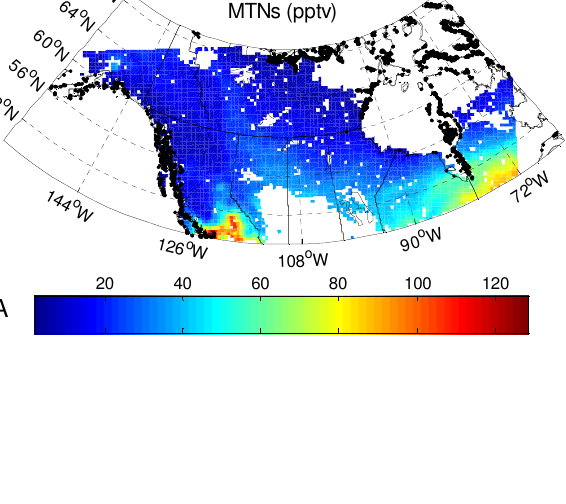
Fig. 7. The 24h, boundary-layer-averaged production rates of MTNs by OH chemistry (red line) and by NO 3 chemistry (black line) as a function of NO x concentration for the BASE case. Each point represents the mean NO x value in each bin. Each bin contains the same number of model grid points (208). Note that the bins are not evenly spaced in terms of NO x concentration.